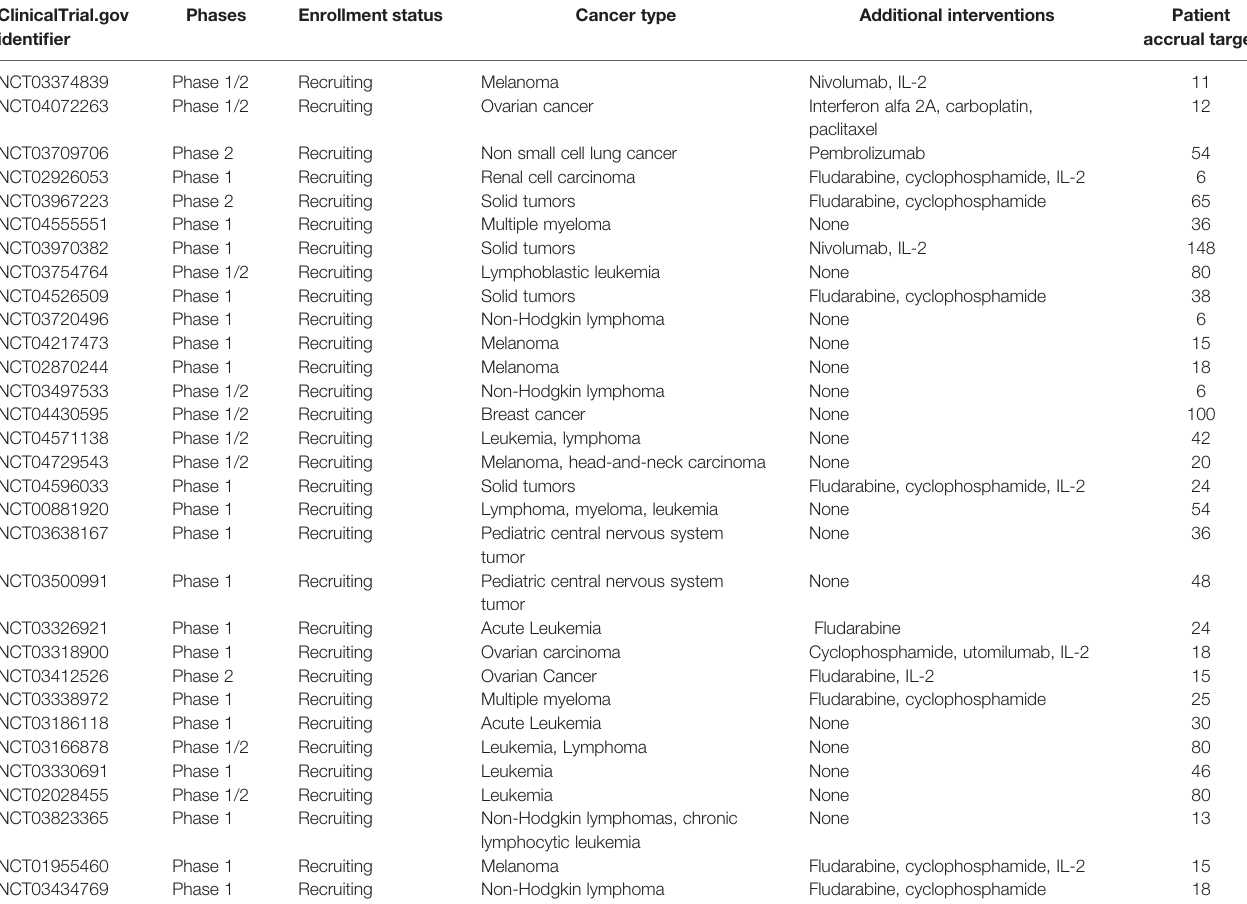
TABLE 2 | Clinical trial of neoantigen ACT. ClinicalTrial.gov identi fi er